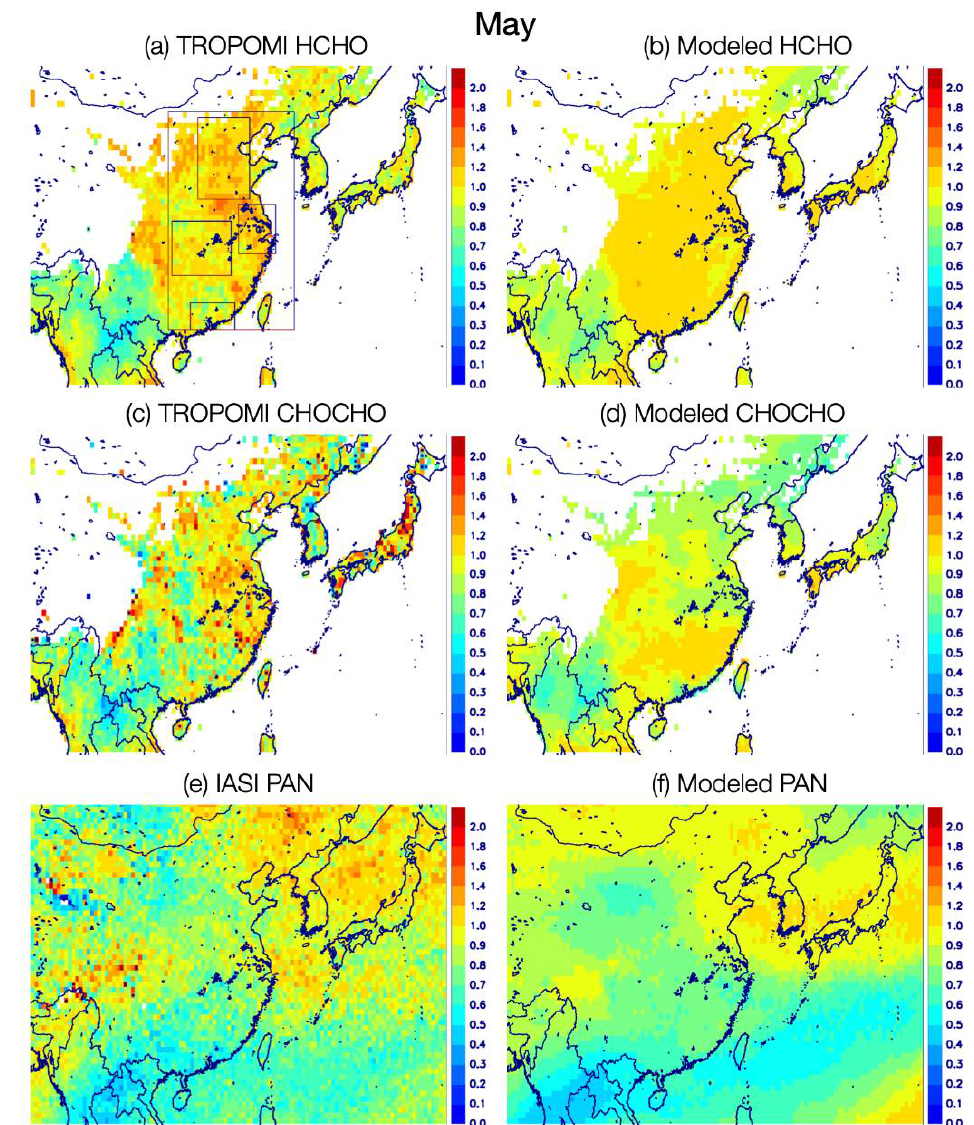
Figure 7. ( a , b ) HCHO column ratio, May 2020 divided by May 2019, according to satellite data ( left ) and to the MAGRITTEv1.1 model ( right ). ( c , d ) Idem for CHOCHO. ( e , f ) Idem for PAN. Invalid data and areas with very low VOC emissions (less than 5 × 10 10 molec.cm −2 s −1 ) are left blank in panels a–d. The stippling in panels a, c, and e indicates data below the estimated detection limit. The boxes of panel ( a ) indicate the analysis regions (also shown on Figure 4).